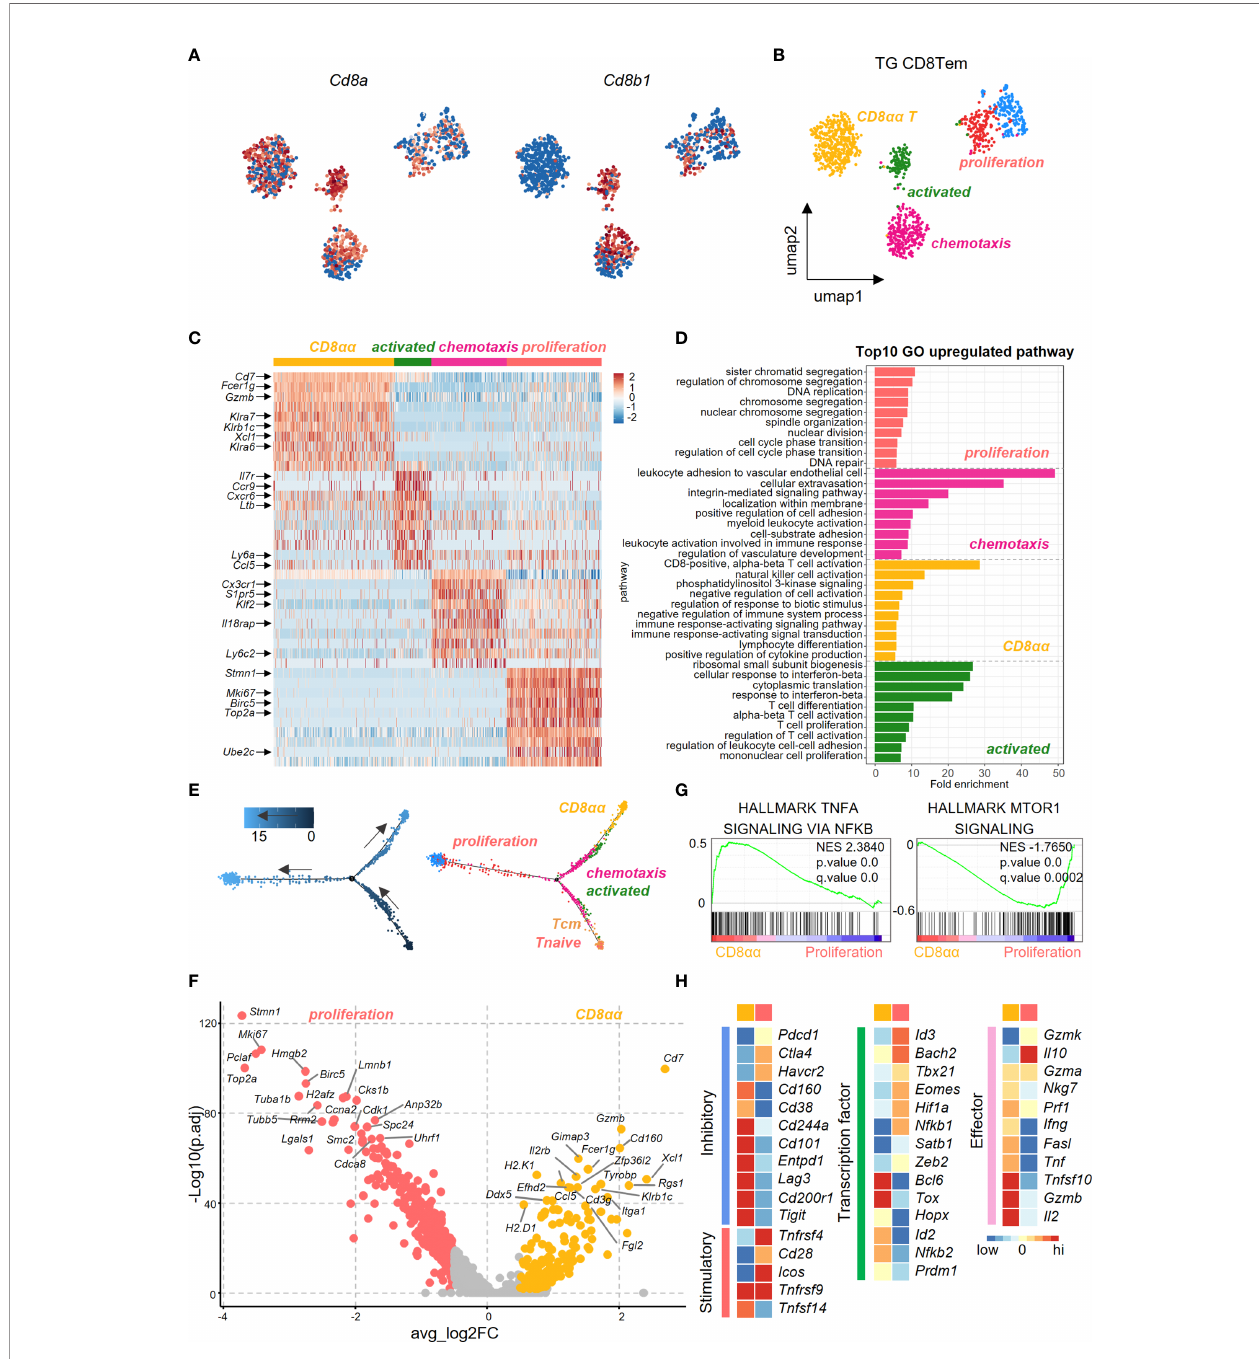
FIGURE 4 | Transcriptional pro fi ling of liver effector memory CD8 + T cells using scRNA-seq. (A) Normalized expression of Cd8a and Cd8b1 in effector memory CD8 + T cells of TG mice. (B) UMAP plot shows the fi ve subpopulations of effector memory CD8 + T cells in TG mice. (C) Scaled average expression of the top 10 upregulated differentially expressed genes for each effector memory CD8 + T subpopulations of TG mice. Individual cells are represented on the horizontal axis and grouped by cluster. (D) GO analysis of the upregulated genes in effector memory CD8 + T subpopulations of TG mice. (E) Pseudotime analysis showed the differentiation trajectory of CD8 + T subpopulations from TG mice. Cells on the tree are colored by pseudotime (left) and subpopulations (right). (F) Volcano plot displayed the DEGs between CD8 aa and proliferation effector memory T cells with the labelling of key signi fi cant genes. Colorized entities represent passing the fi lter of p_val_adj < 0.01 and ave_log2FC > 0.5 (< -0.5) with golden (jacinth) gradient on ave_log2FC values. (G) GSEA analysis of TNF a -NF k B signaling and mTOR1 signaling between CD8 aa and proliferation effector memory T cells. The normalized enrichment score (NES), original p value and FDR adjusted p values (q.value) are shown. (H) Scaled average expression of inhibitory and costimulatory checkpoint molecules (left), transcription factor molecules (middle) and effector molecules (right) for CD8 + T sub-population of CD8 aa and proliferation effector memory T